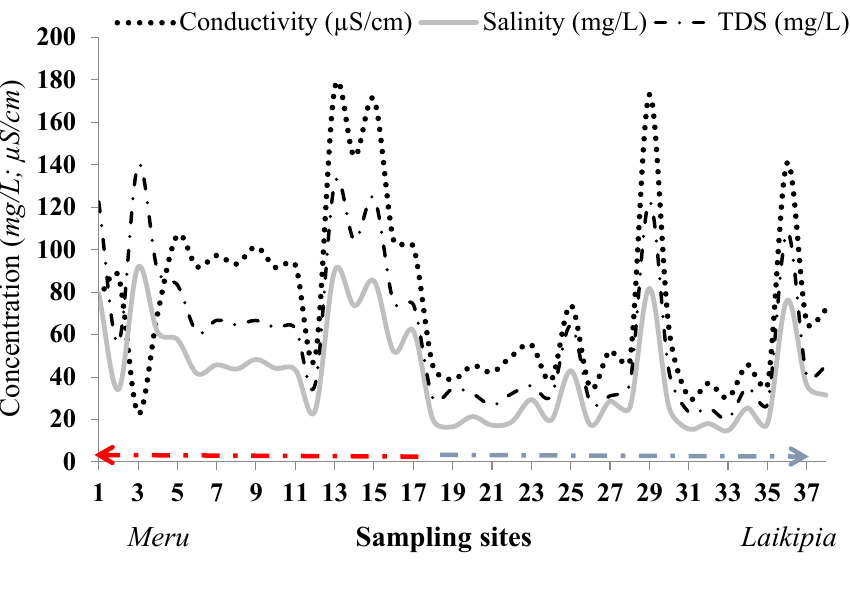
Figure 2. A scatterplot showing the spatial variation of electrical conductivity (EC, in µS/cm), salinity, and total dissolved substances (TDS) concentrations (mg/L) across the sites in Meru (red line) and Laikipia (blue line).